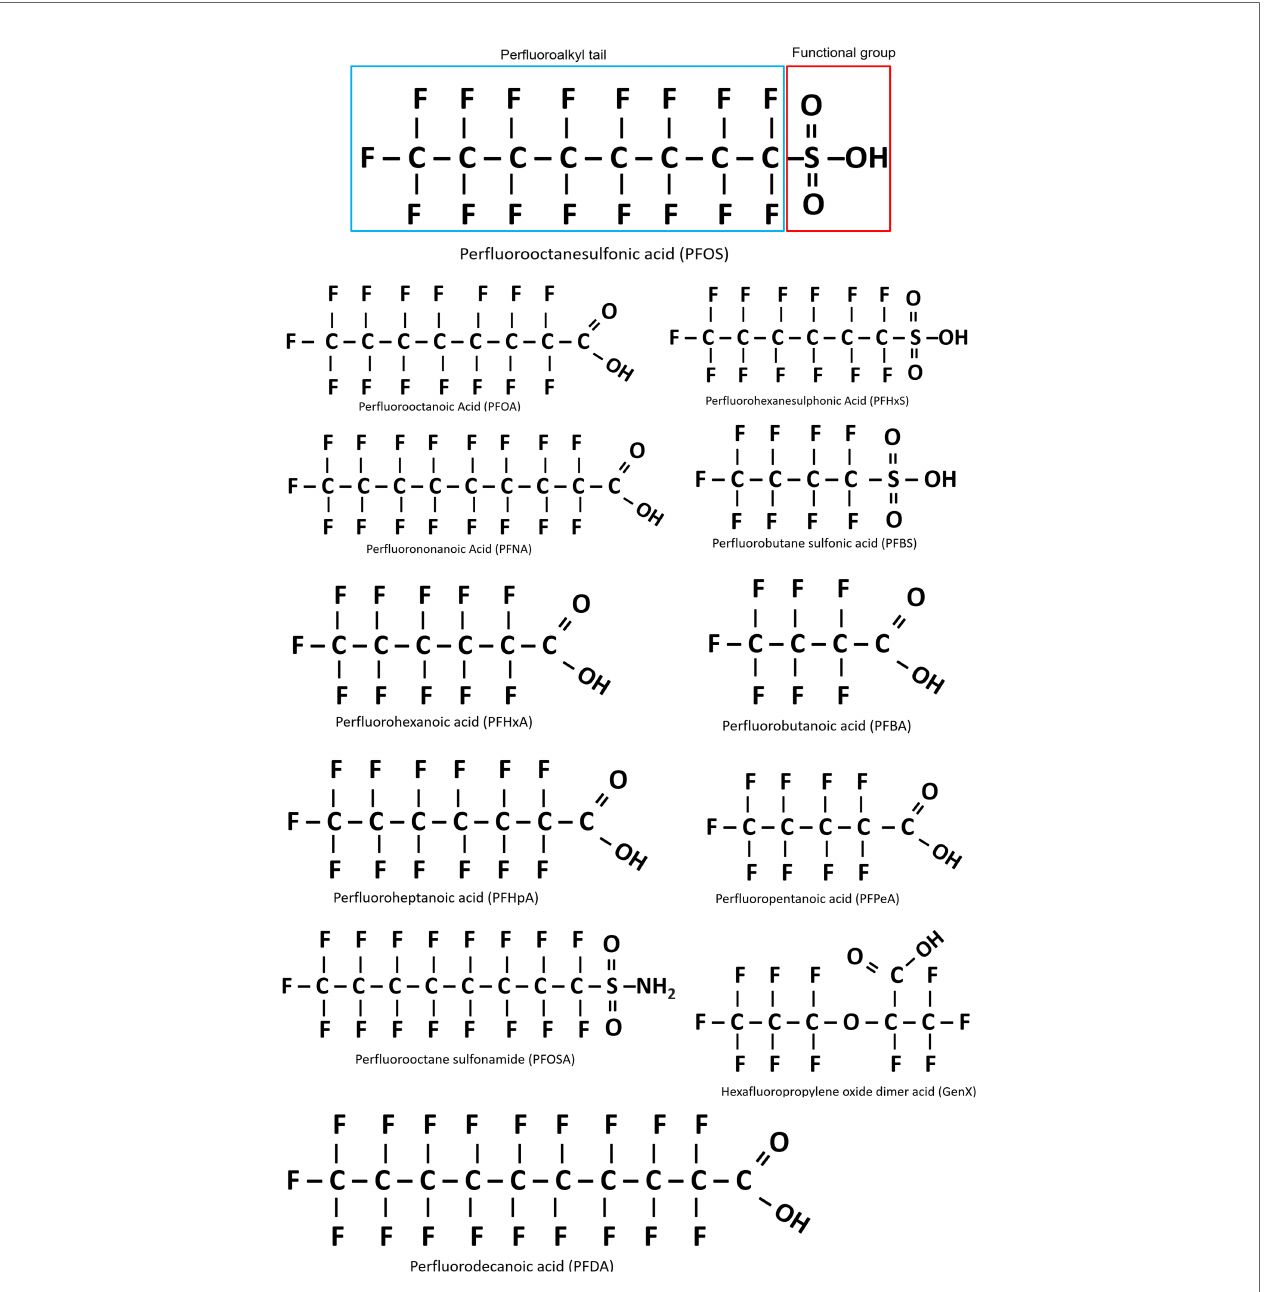
FIGURE 1 | Basic structure of per fl uoroalkyl substances (PFAS), using per fl uorooctanesulfonic acid (PFOS) as an example. Outlined in blue is the per fl uoroalkyl tail (carbon/ fl uoride chain) and the functional group is outlined in red. All PFAS share these general features, with variation in the carbon chain length and functional group. Figure adapted from Blake and Fenton 2020